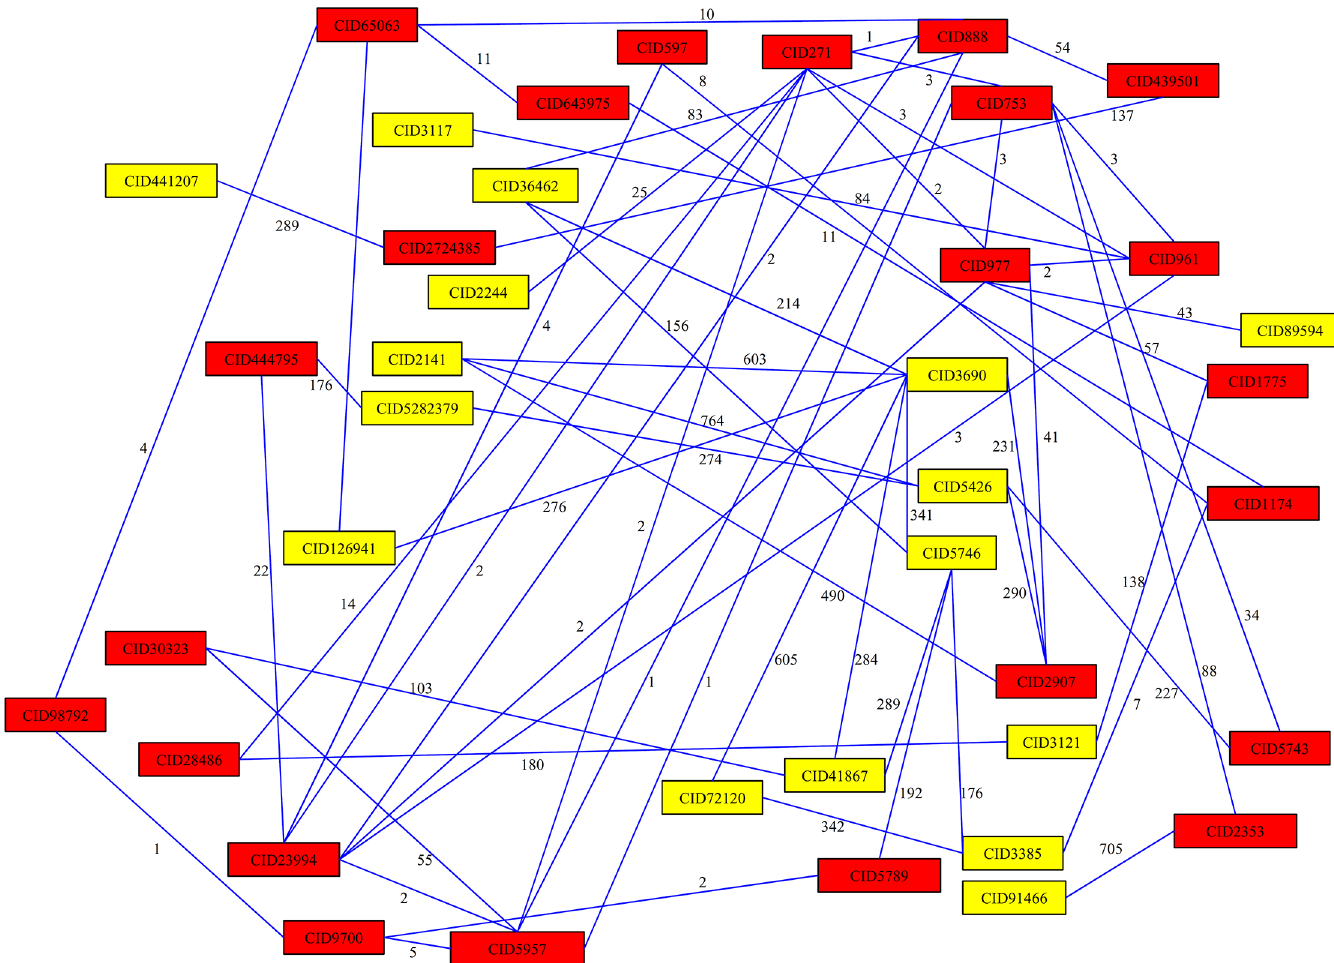
Fig 1. 120 shortest paths connecting 16 NSCLC-related chemicals, which were obtained by applying Dijkstra ’ s algorithm in the constructed network. Yellow rectangles represent 16 NSCLC-related chemicals, and red rectangles represent 23 other chemicals involved in these 120 shortest paths. Numbers on edges represent edge weights in the